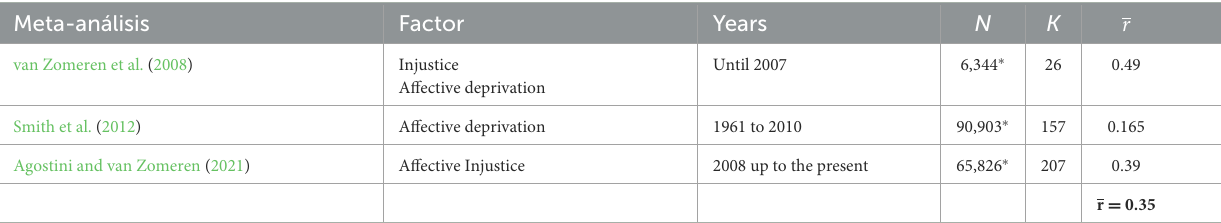
TABLE 6 Relationship of affective deprivation and injustice with SM and